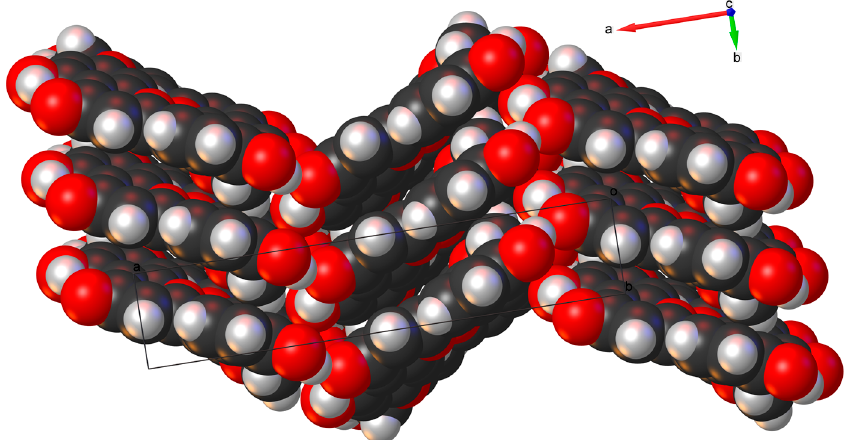
Figure 5. The crystal structure consists of layers that are made up of chains of Genkwanin molecules bridged by hydrogen bonds along the a -axis, with adjacent chains linked by infinite π - π interactions along the b -axis. The layers are held together by weaker van der Waals forces along the c -axis.